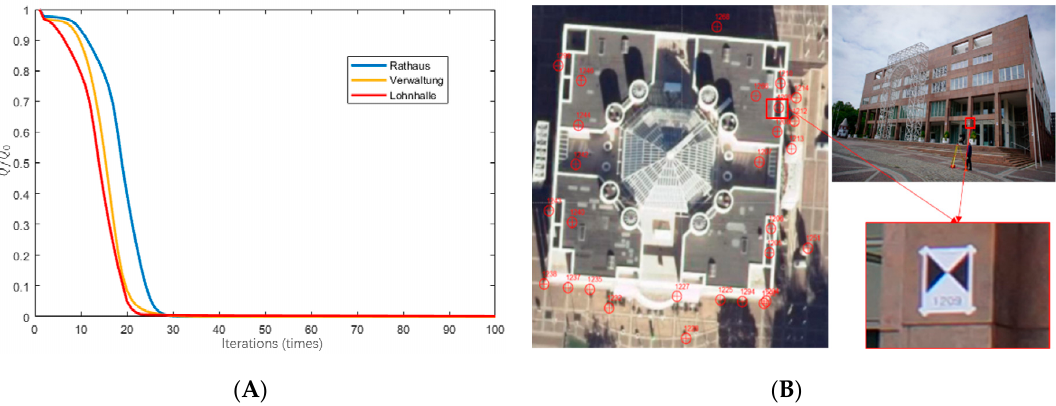
Figure 9. ( A ) Likelihood function Q relative to the initial value Q 0 as a function of the number of iterations. ( B ) Illustration of ground targets.